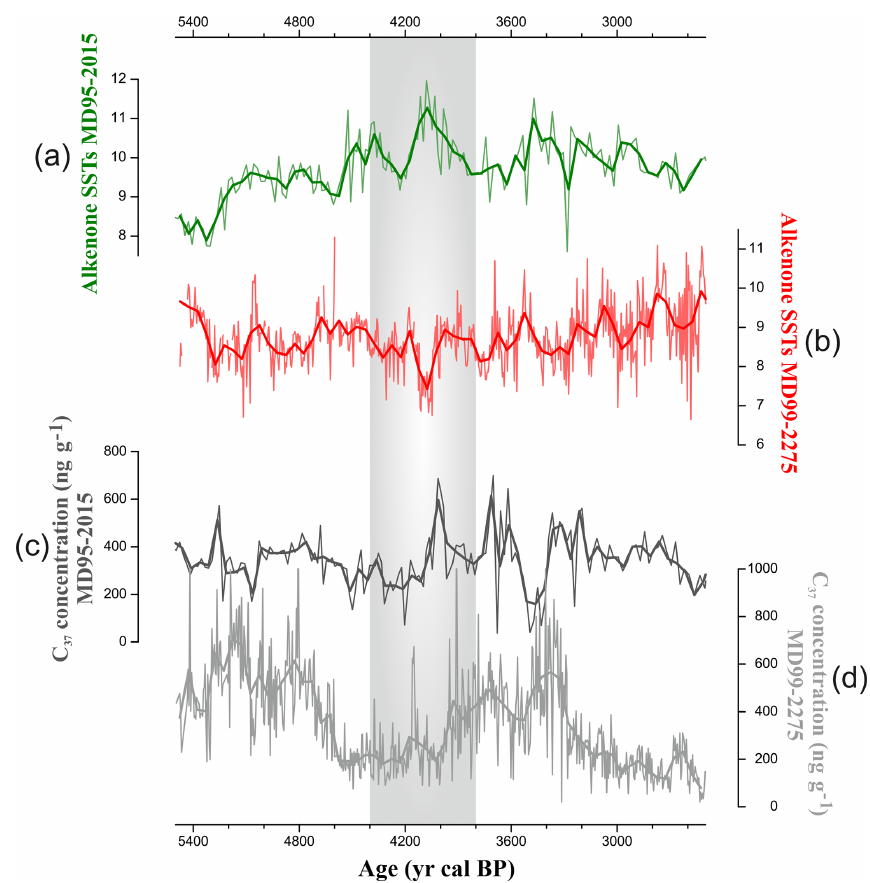
Figure 2. Alkenone-derived sea surface temperatures (SSTs) in the North Atlantic cores between 5500 and 2500calBP. (a) At the MD95- 2015 core (site 1 in Fig. 1) and (b) at the MD99-2275 core (site 2 in Fig. 1). (c) C 37 alkenone concentrations (in ngg − 1 dry sediment) at the MD95-2015 core and (d) MD99-2275 core. Fifty-year binning is applied to reduce the effect of proxy reconstruction error (thick lines). The grey vertical band represents the 4.2kaBP event time interval